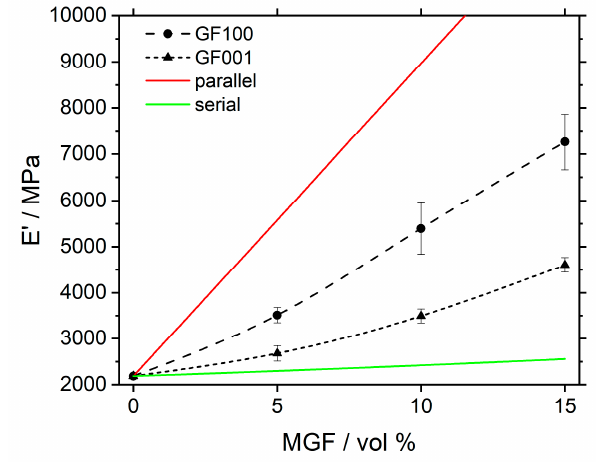
Figure 18. Storage modulus E’ at 25 °C with different volume fractions of GF100 ( d 50 = 160 µm) and GF001 ( d 50 = 30 µm).